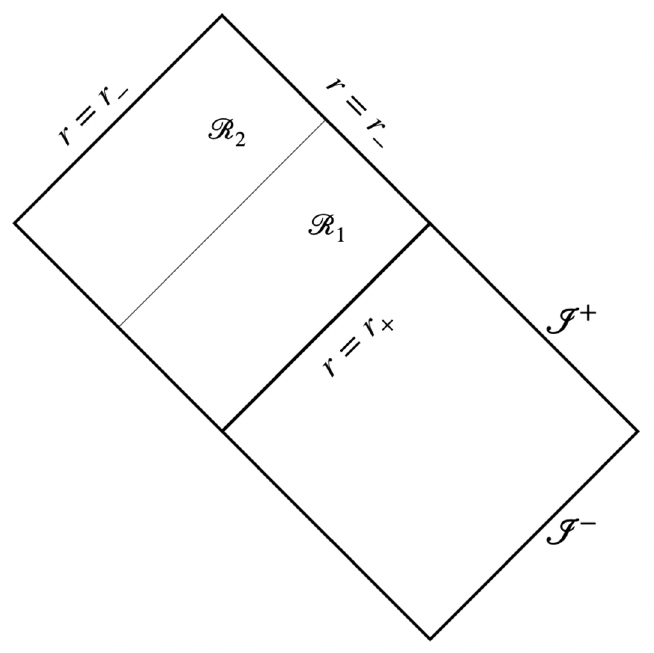
Figure 2 . Schematic representation of the relevant sections of the Carter-Penrose diagram of a regular black hole. An outgoing null shell divides the spacetime in two